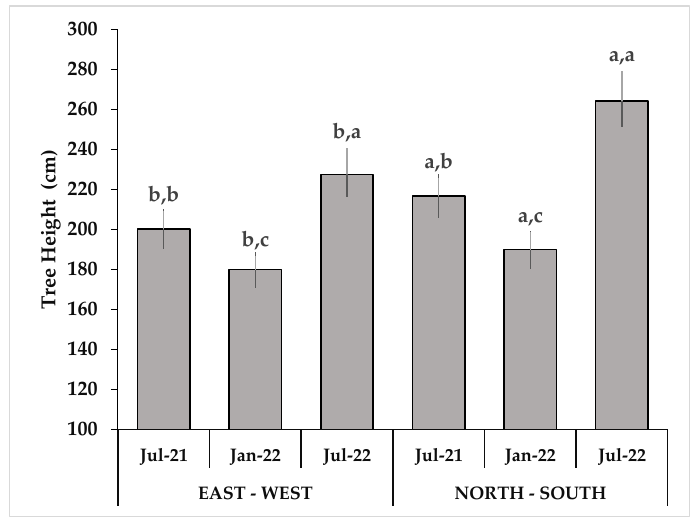
Figure 2. Tree height (cm) values in E – W and N – S orientations of a SHD almond orchard in 2021 and 2022. First letters denote statistical differences between row orientations; second letters denote statistical differences among different moments of observations ( p = 0.05; SNK test).